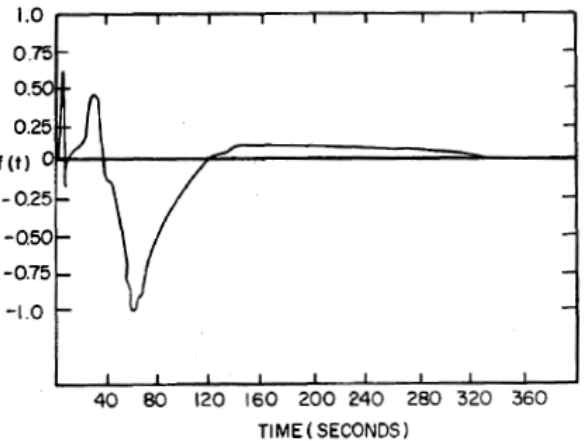
Figure 2. Time-varying, spatially-independent time scalar f ( t ) of the electric field model proposed by the Oak Ridge National Laboratory (ORNL) for the E3 HEMP-generated electric field [11]. [Courtesy of Oak Ridge National Laboratory, U.S. Dept. of Energy]